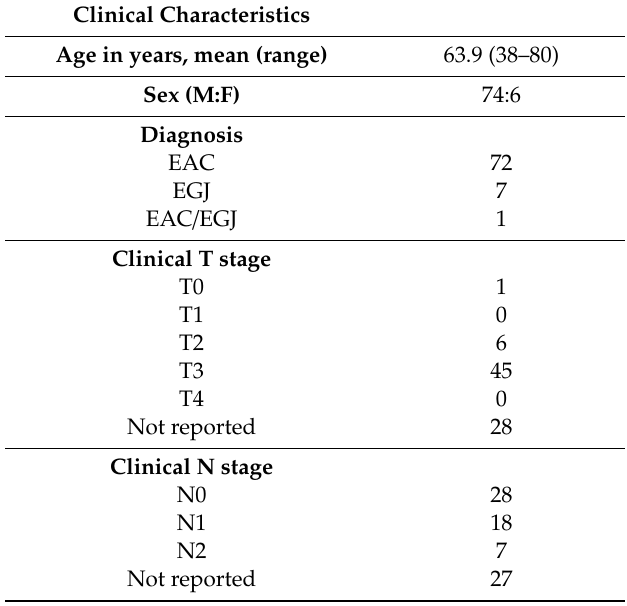
Table 1. Patient demographics for pre-treatment serum ELISA analysis, n =